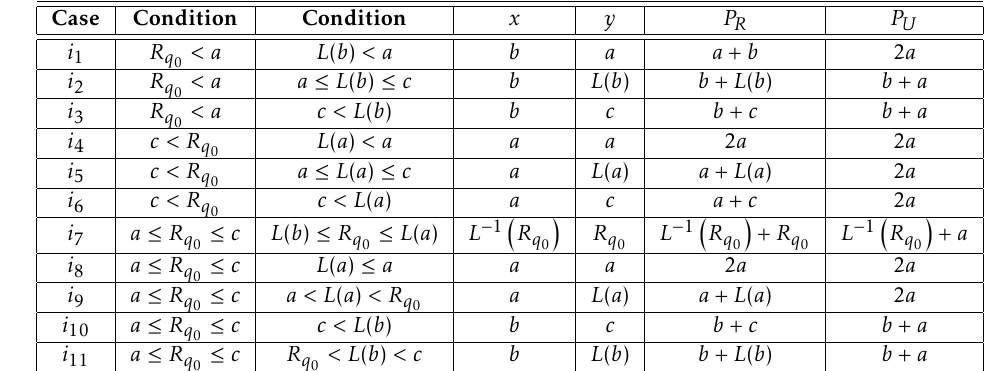
− 2( C − F − (1 − q and P and P are detection 0 ) V ) / ( q 0 V ) q 0 ) = T S R U